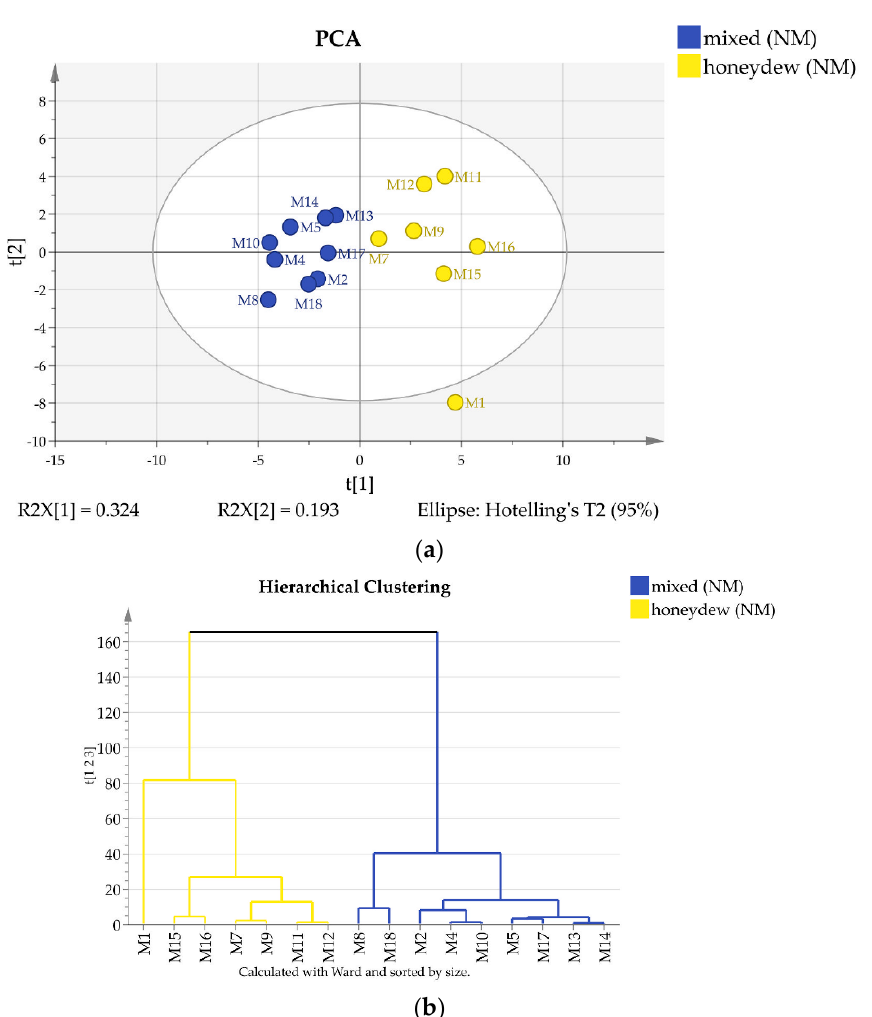
Figure 3. ( a ) 2D score PCA plot of Bulgarian honey samples using quantities of all components; ( b ) Dendrogram of Bulgarian honey samples.